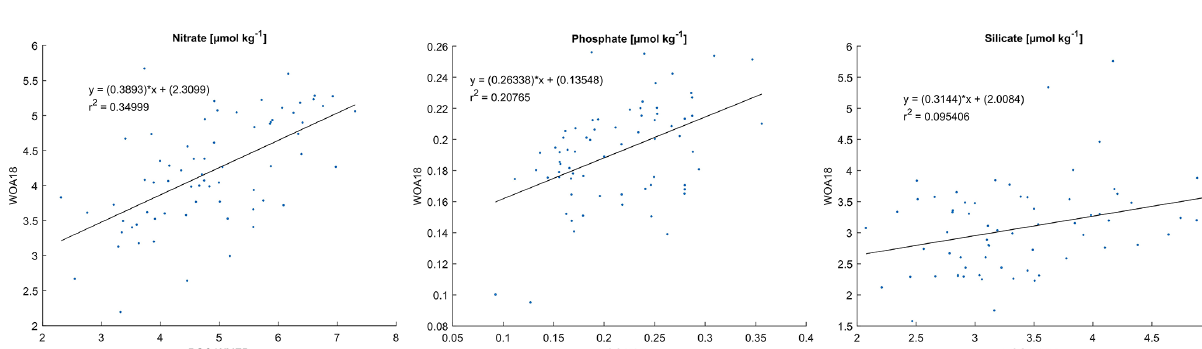
Figure 13. The same as Fig. 11 but for silicate.